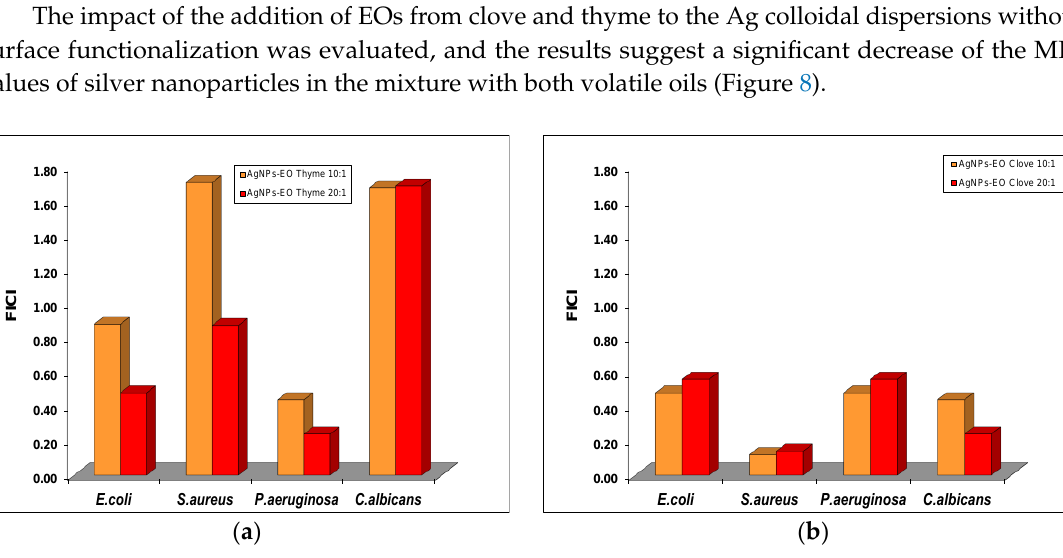
Figure 9. The variation of the fractional inhibitory concentration index (FICI) of mixed systems with AgNPs stabilized with 1% LMW chitosan and essential oils. ( a ) Thyme oil; ( b ) Clove oil.